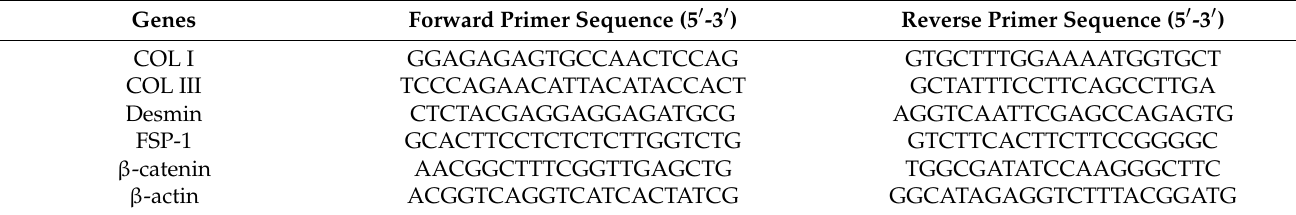
Table 1. Primers sequence for quantitative real-time